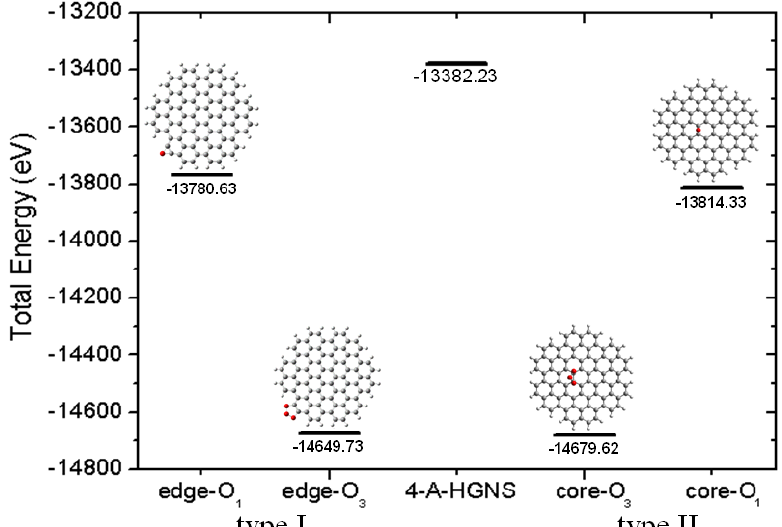
Figure 5. Two isomers of the epoxide substitution 4-A-HGNS considered for comparison of their energies; one has the oxygen atom in the edge ( type I ), and the other has the oxygen atom located in the core of 4-A-HGNS ( type II ). The energies are calculated by the PBE/GGA/SIESTA